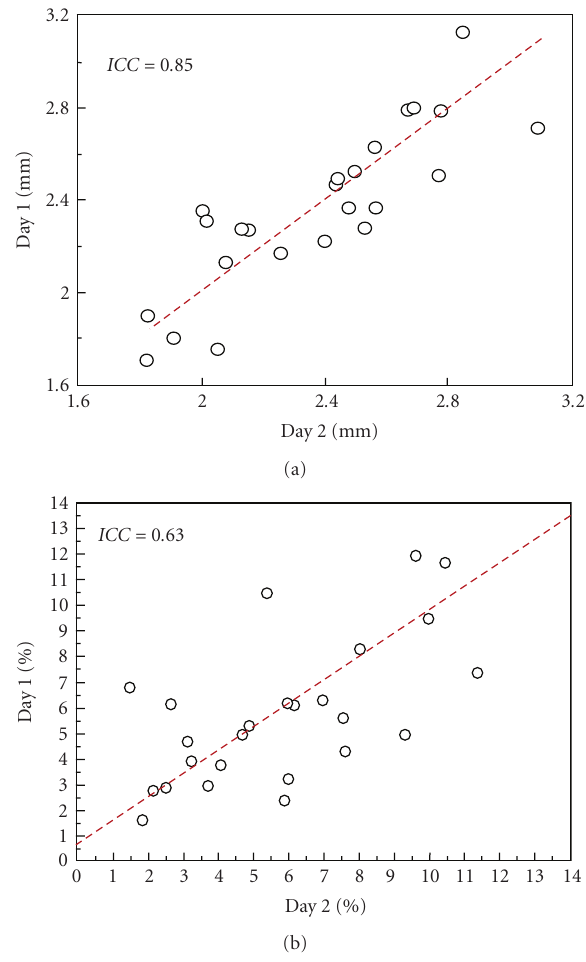
Figure 6: Correlation between repeated measurements in 25 healthy subjects studied twice with a delay of 24 hours. (a) Resting diameter; (b) FMD. The interclass correlation coe ffi cients are ICC = 0 . 85 and ICC = 0 . 63, respectively.